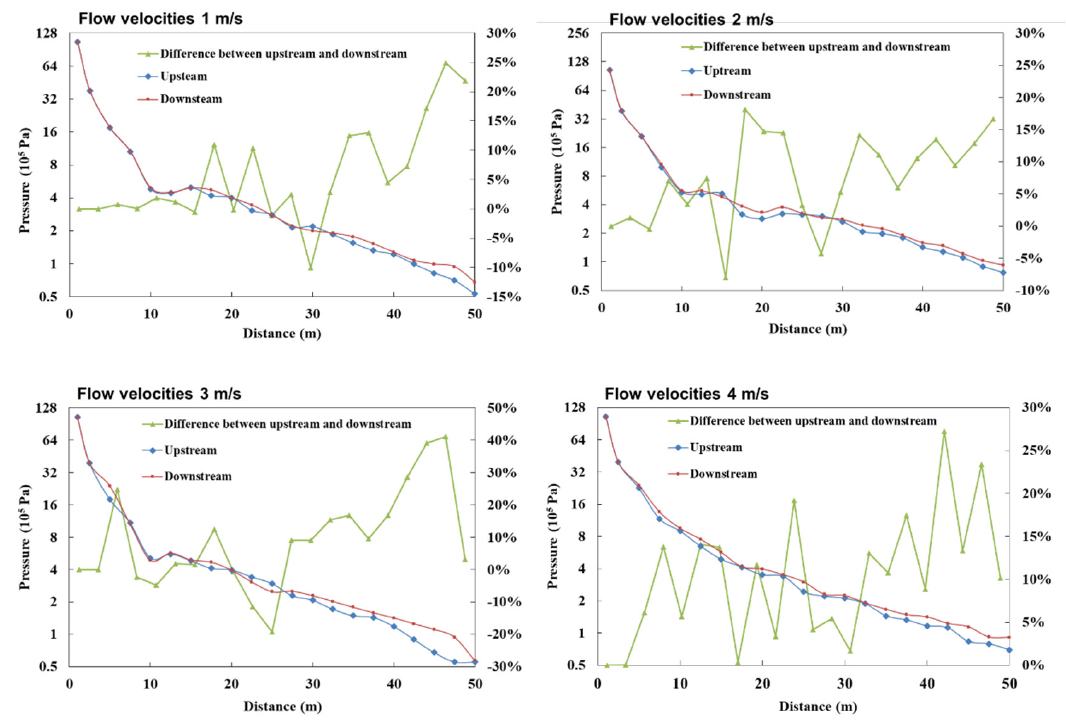
Figure 11. Shock wave pressure upstream and downstream.